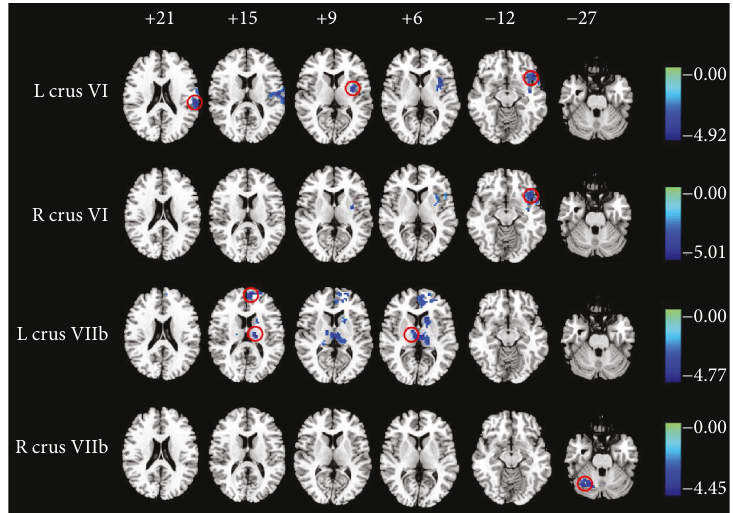
Figure 3: Whole-brain analysis of functional connectivity (FC) of nine cerebellum subregions. Decreased cerebellar-cerebral FC in SNHL patients compared to healthy controls indicated by colour ( p < 0 01 , family-wise error corrected). The colour heat map scale at the right shows t values. R: right; L: left. Table 2: Decreased functional connectivity in SNHL subjects compared with healthy controls.